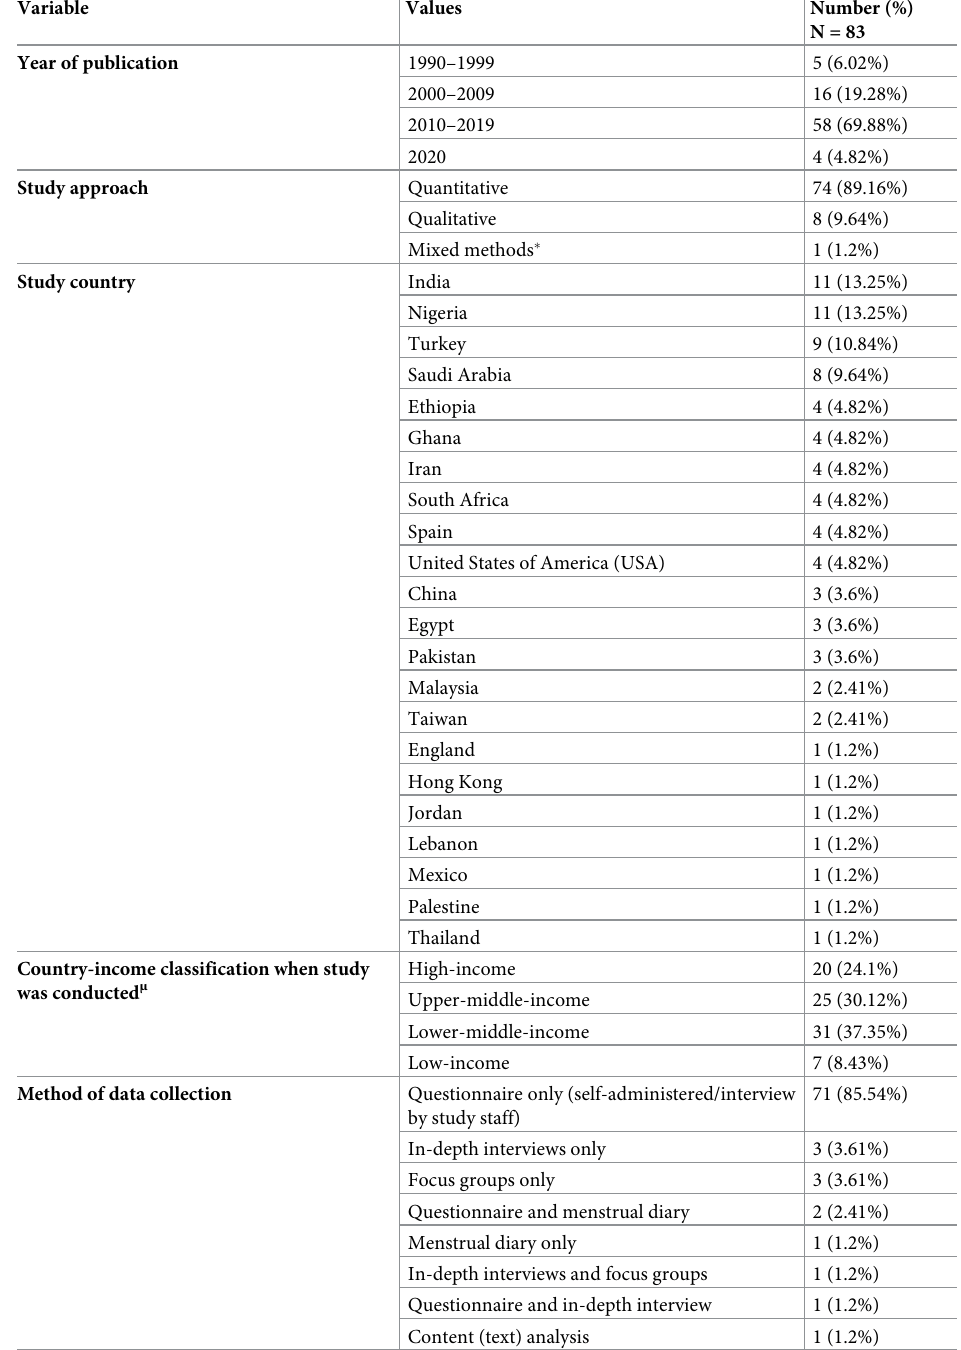
Table 1. Characteristics of included studies in this